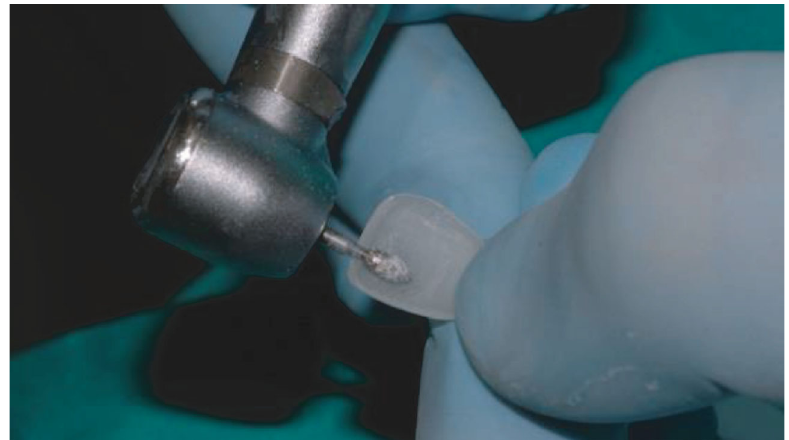
Figure 5: Internal adjustments to reduce the thickness of the veneer.